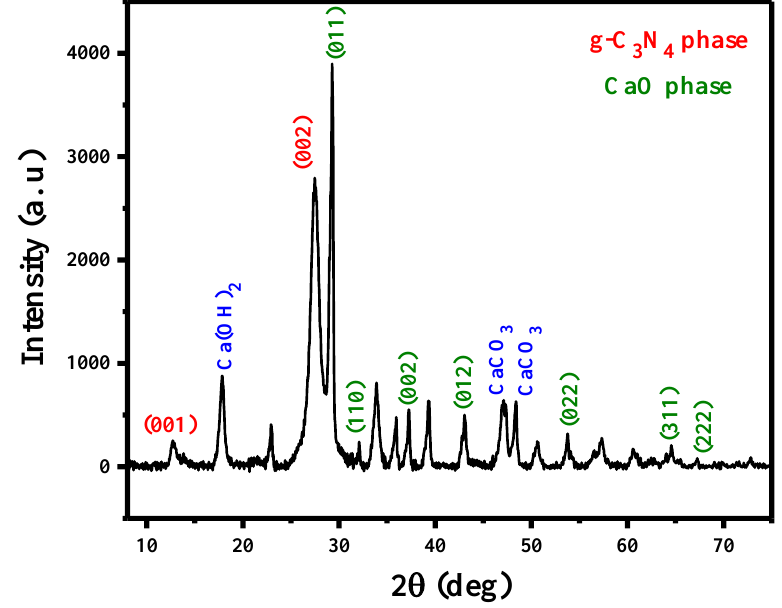
Figure 3. XRD patterns of CaO-g-C 3 N 4 nanosorbent.